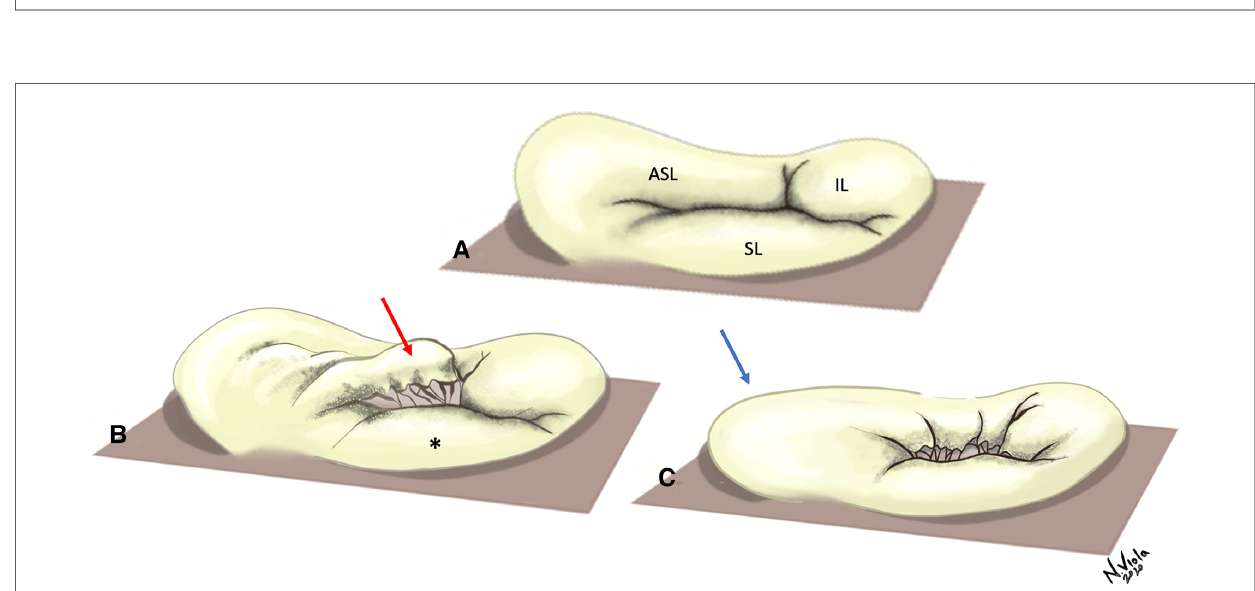
FIGURE 5 Typical pathology of the tricuspid valve in surgically palliated HLHS. ( A ) Normal TV valve, with a wave-like annulus and normally coapting lea fl ets. ( B ) Prolapse of the ASL (red arrow) and small SL (*), resulting in inadequate coaptation at the anteroseptal commissure and antero-superior fl attening of the annulus. ( C ) Tethering of both SL and ASL, with failure of coaptation and marked fl attening of the annulus across the cycle (blue arrow). ASL, Antero-superior lea fl et; SL, Septal lea fl et; IL, Inferior lea fl